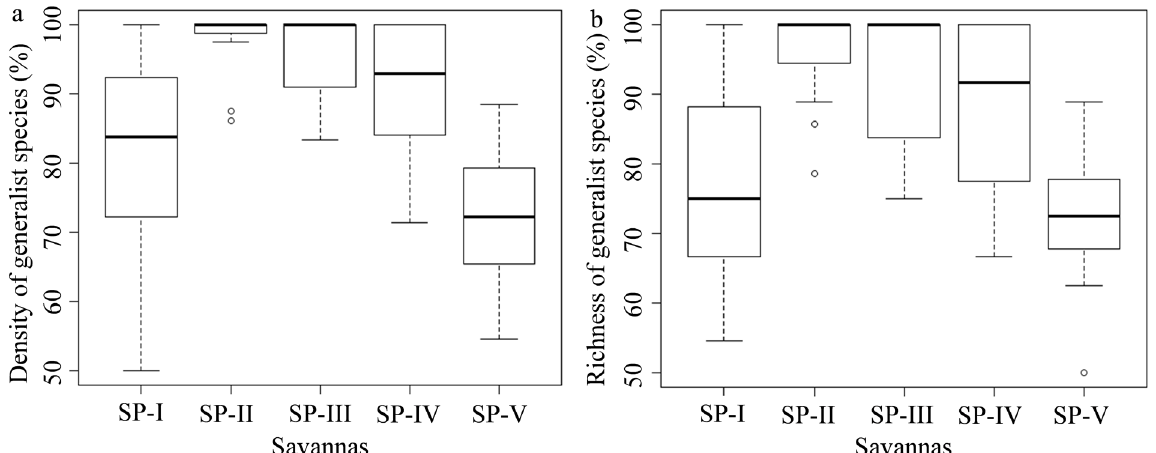
Figure 6. Generalist species in the sampled areas. (a) Density; (b)